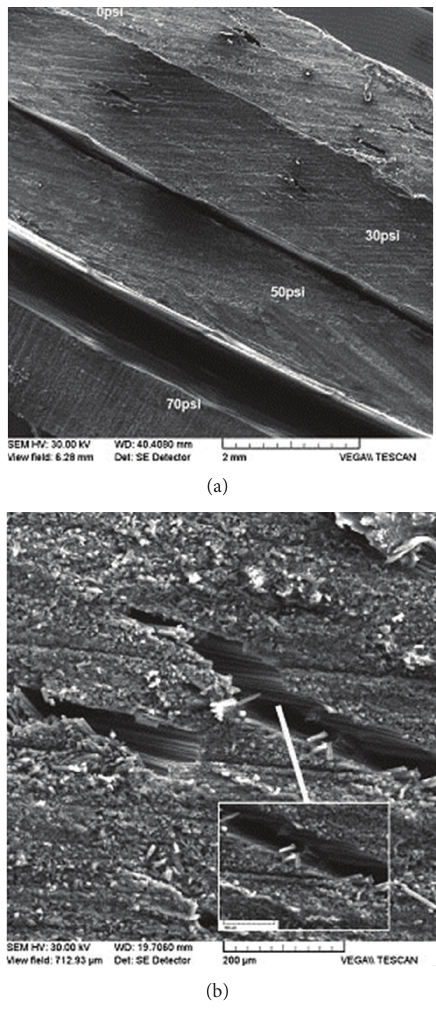
Figure 7: (a) All different samples manufactured in different pressures. (b) Samples manufactured at 0psi, showing increased void